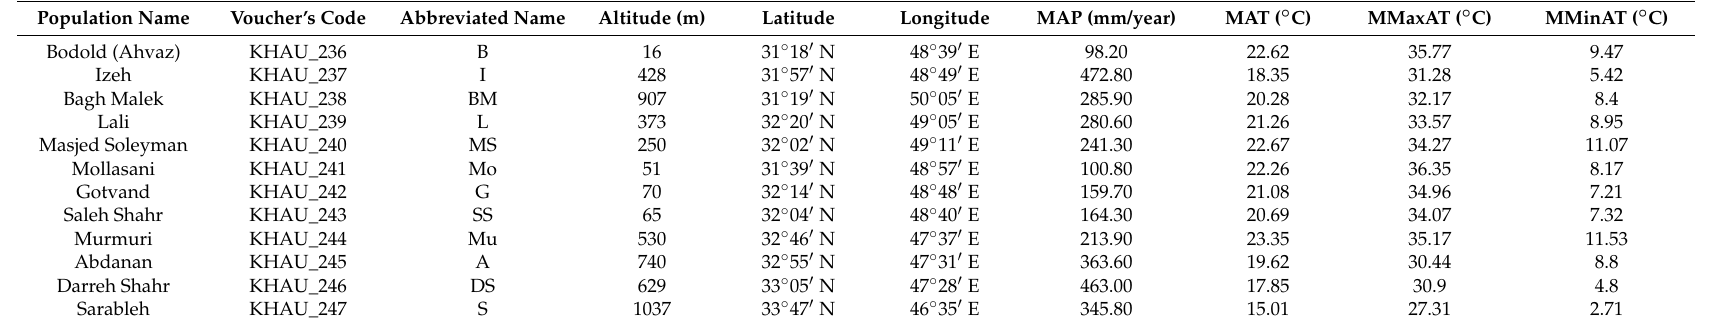
Table 3. Geographic locations and climatic conditions of the studied Matricaria chamomilla populations from